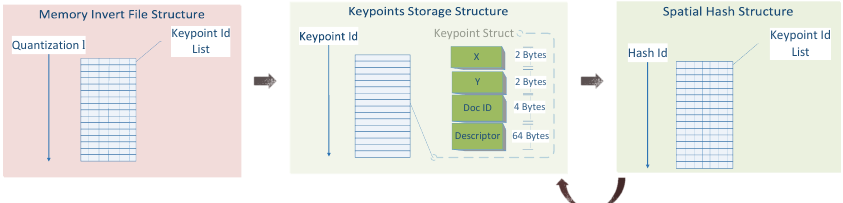
Figure 7. Memory and storage structures and their